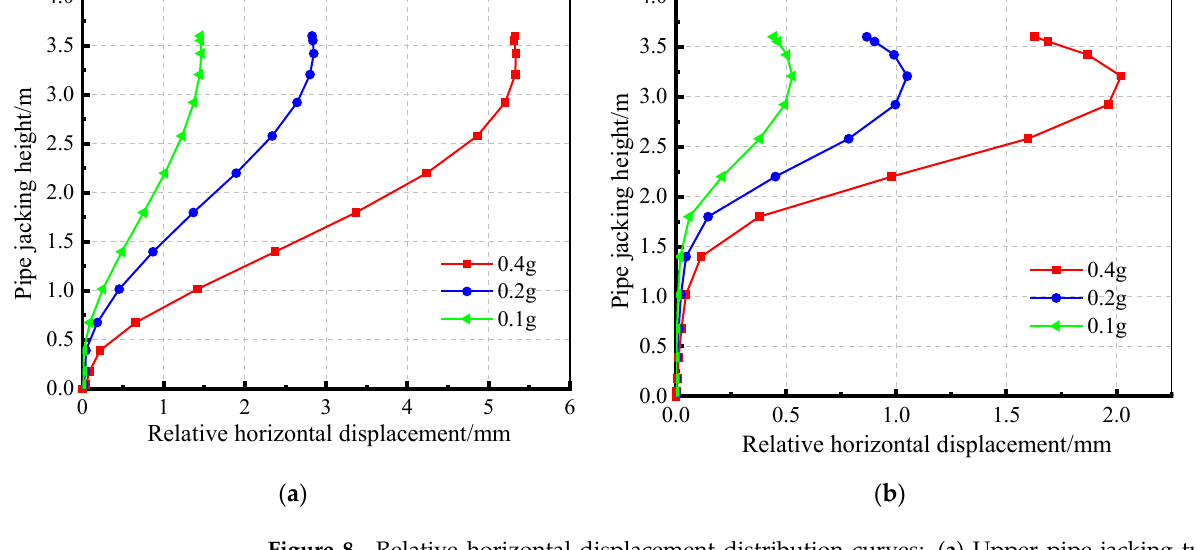
Figure 8. Relative horizontal displacement distribution curves: ( a ) Upper pipe jacking tunnel; ( b ) Lower pipe jacking tunnel.